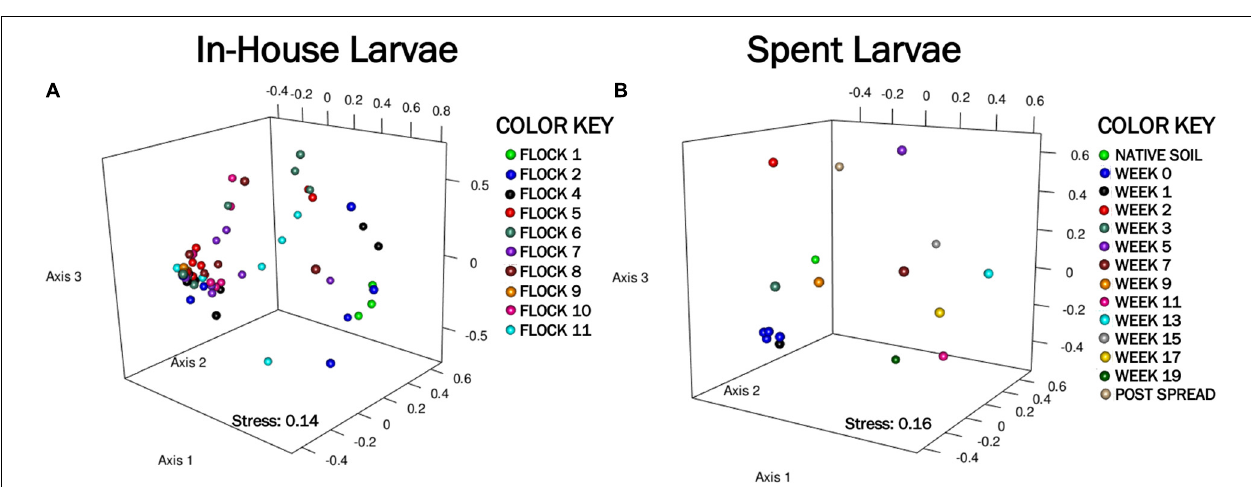
FIGURE 2 | A nonmetric multidimensional scaling (NMDS) ordination representing the bacterial community composition associated with larvae, generated using Yue and Clayton distances, shows dissimilarities between components. (A) Shows clustering of the In-House Larvae (stress = 0.14, r 2 = 0) over 11 flock rotations. (B) Shows clustering of the Spent Larvae (stress = 0.16, r 2 = 0) through 19 weeks after piling in